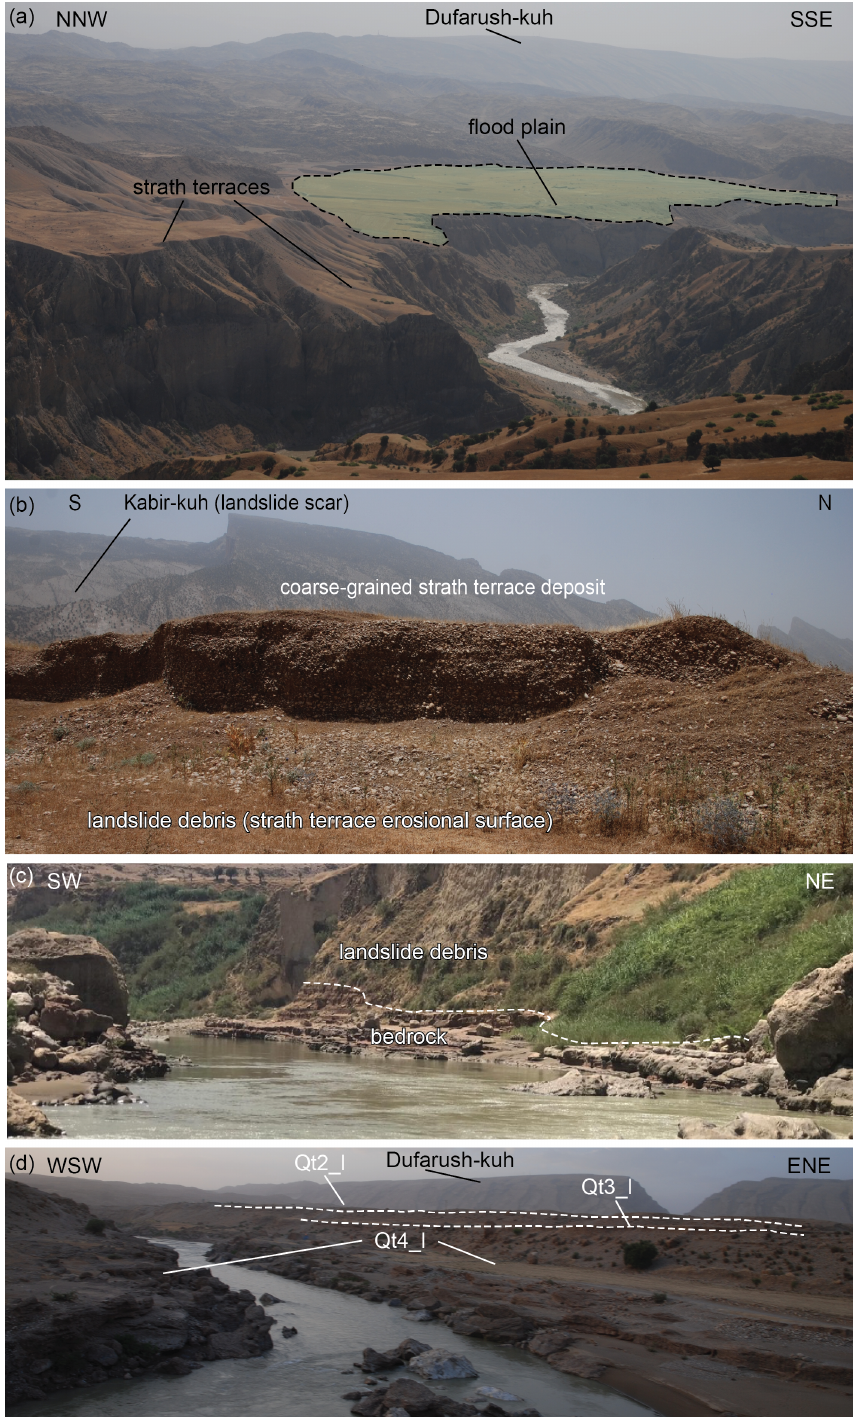
Figure 7. Geomorphic markers upstream of the Seymareh landslide. (a) Strath terraces and a flood plain developed over the landslide debris, which are important markers of the evolution of the natural dam since they testify to the overcoming of the damming lake and the overflooding of the river onto the landslide debris, respectively; (b) detail of the strath terrace deposit sampled for OSL dating; (c) bedrock exposure below the landslide debris along the modern river profile passing through the relict landslide dam; (d) the suite of fluvial terraces downstream of the Seymareh landslide; the Qt1 level is poorly preserved and not visible in this